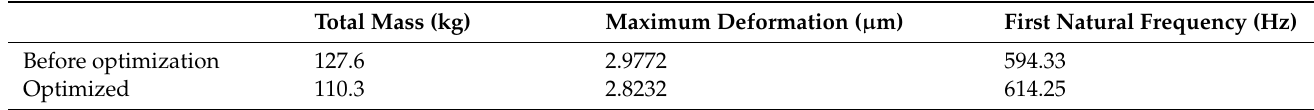
Table 10. Comparison of parameters before and after optimization of direct-drive turntable.